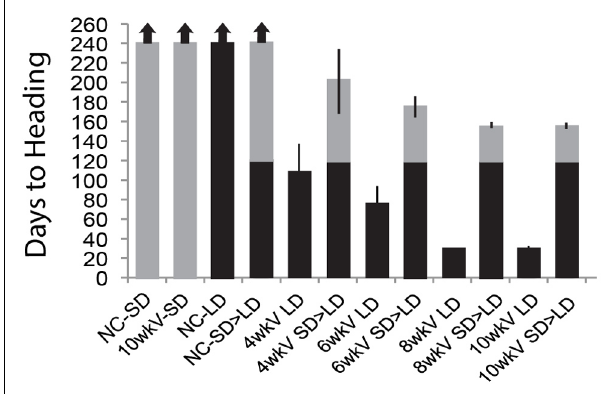
FIGURE 2 | Increasing duration of cold exposure causes increasingly rapid flowering in Brachypodium regardless of whether or not prolonged growth in SD separates cold exposure from inductive LD. Plants were vernalized for 4, 6, 8, and 10 weeks then placed into either SD for 120 days followed by a shift into LD or placed directly into LD. Flowering time was measured as days to heading upon emergence of first spikelet, and the time of cold exposure (vernalization treatment) was excluded. Arrows indicate plants that did not flower at end of experiment (240 days). Bars represent the days to heading average of six plants (experiment was repeated with similar results). LD = 20-h long days (gray bars), SD = 8-h short days (black bars), SD > LD = shift after growth in SD for 120 days into LD (black and gray bars). Plants were grown and scored as described in Ream etal.